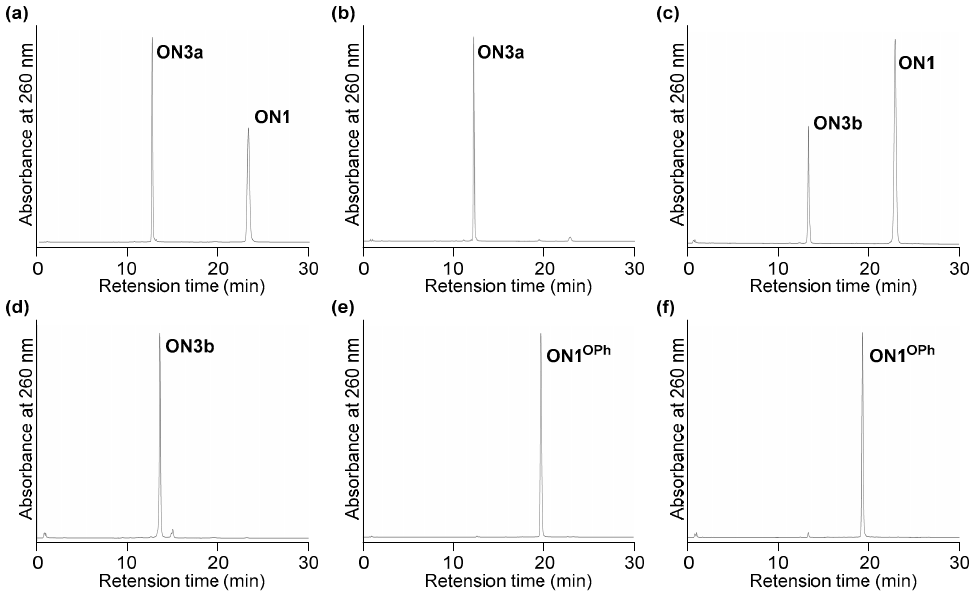
Figure 2. HPLC profiles of the crude products after post-synthetic modification: ( a ) Treatment of ON1 with 10 M NH 3 aq. at 30 °C for 4 h; ( b ) Treatment of ON1 with 10 M NH 3 aq. at 30 °C for 24 h; ( c ) Treatment of ON1 with 0.1 M MeNH 2 aq. at 30 °C for 2 h; ( d ) Treatment of ON1 with 0.5 M MeNH 2 aq. at 30 °C for 4 h; ( e ) Treatment of ON1 OPh with 10 M NH 3 aq. at 30 °C for 24 h; ( f ) Treatment of ON1 OPh with 0.5 M MeNH 2 aq. at 30 °C for 24 h.